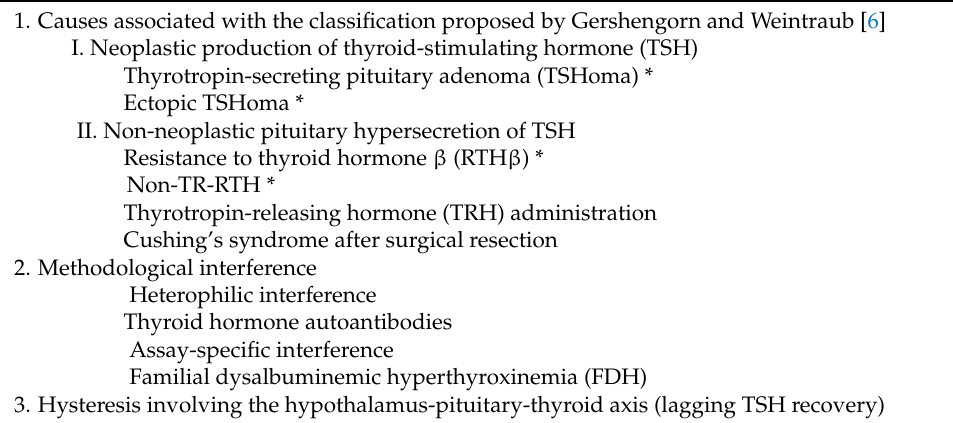
Table 1. Possible causes of inappropriate secretion of thyroid-stimulating hormone